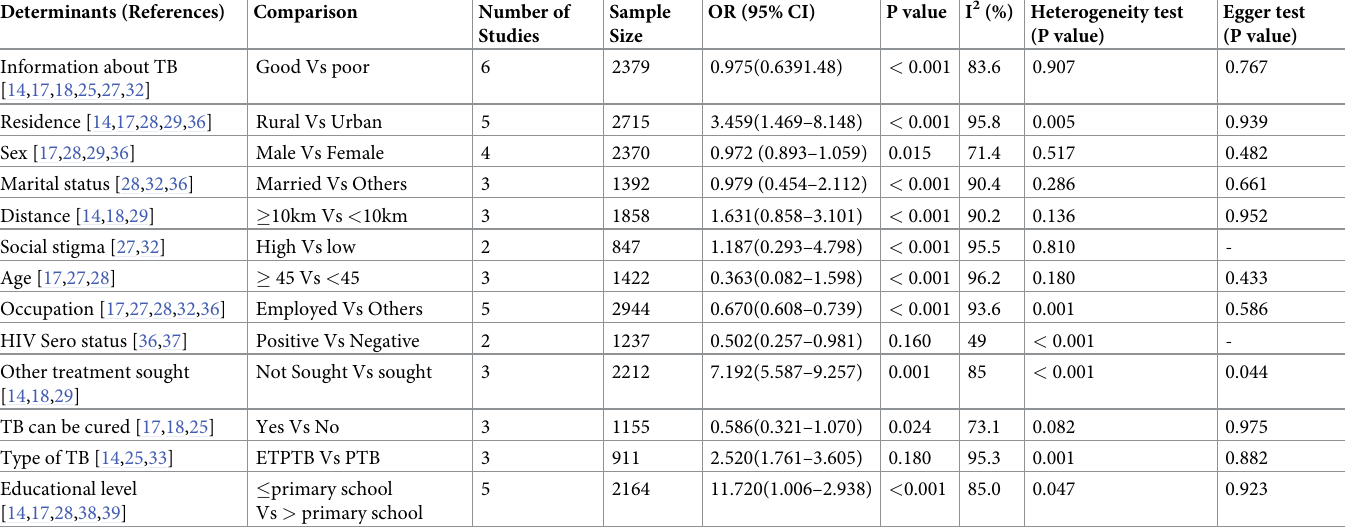
Table 4. Factors associated with delay in seeking health care among tuberculosis patients visited health facilities in